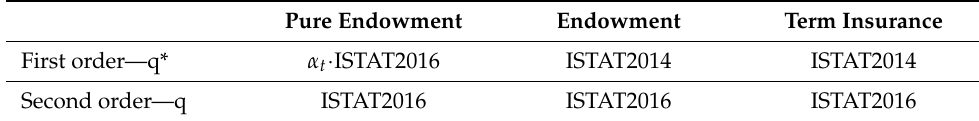
Table 3. Demgraphic